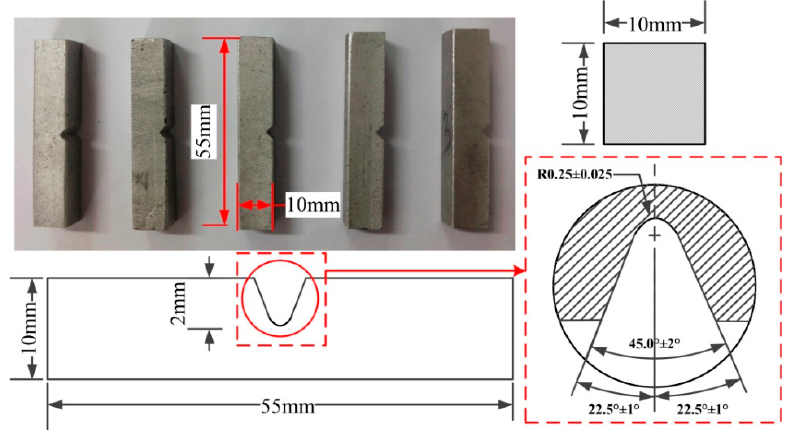
Figure 2. The dimensions of the impact specimen.